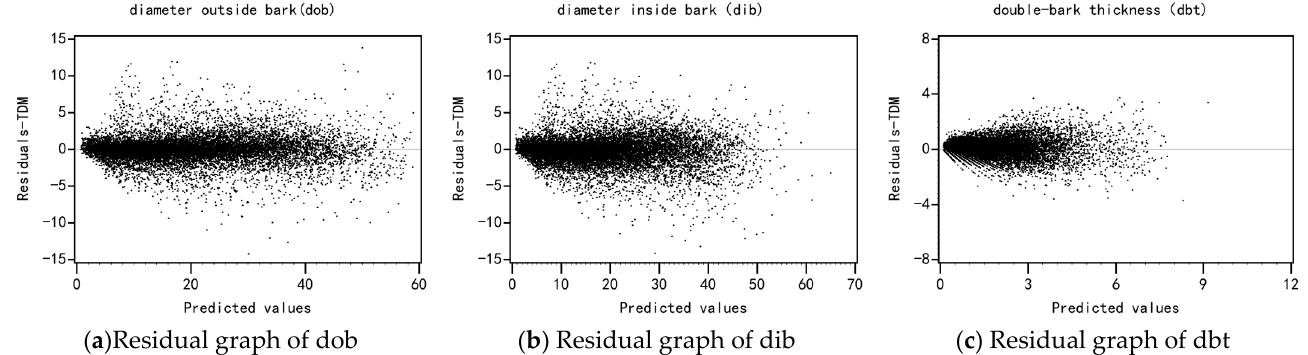
Figure 2. Residual graphs of an additive system for dob, dib and dbt with TDM methods.